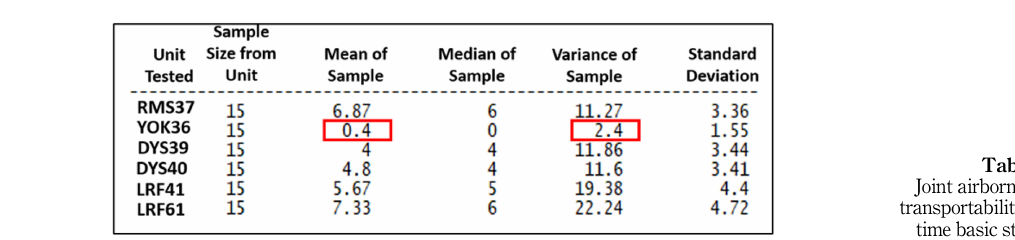
Table A7. Joint airborne or